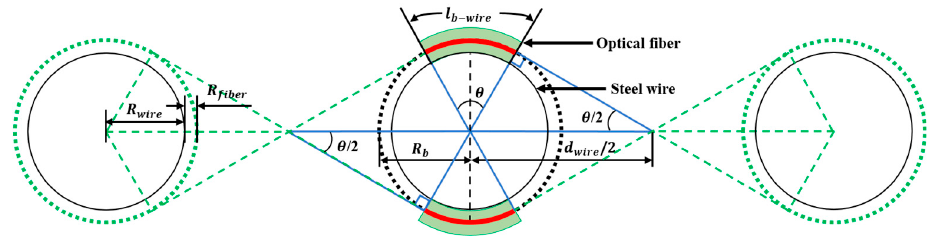
Figure 2. Schematic of the twisted dual-cycle bending length 𝑙 (cid:3029)(cid:2879)(cid:3050)(cid:3036)(cid:3045)(cid:3032) .